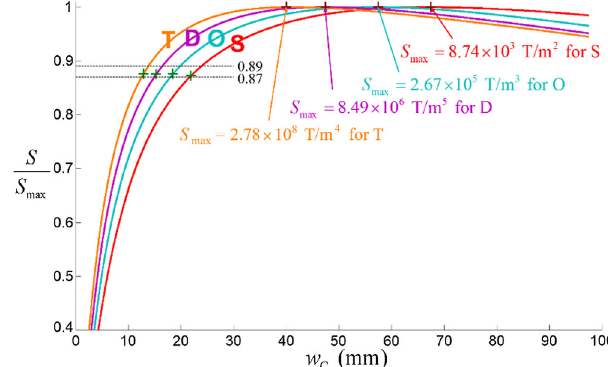
FIG. 5. Strength at 80% along the magnet load line normalized to its maximum value versus coil width w magnets ranging from sextupole to dodecapole (SODT) without iron poles.